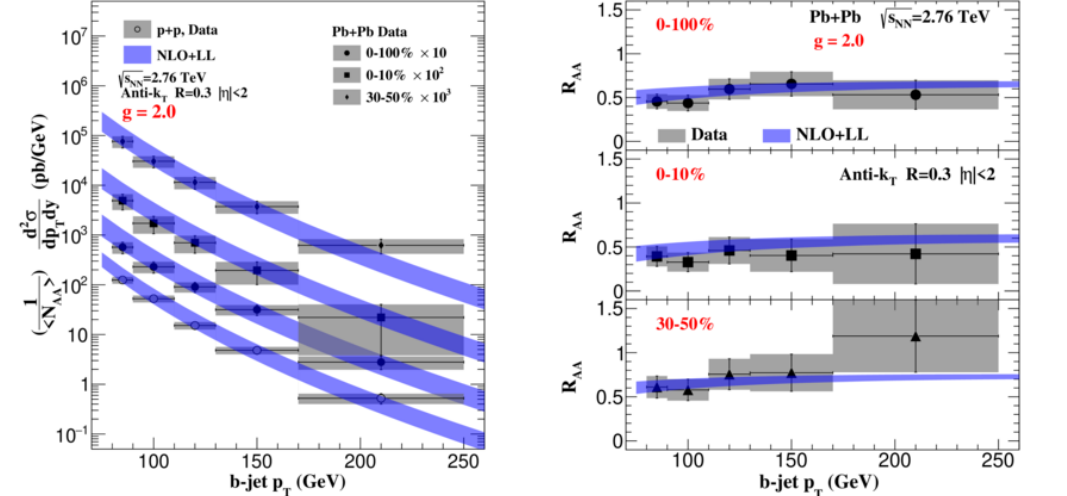
Figure 6 . The b-jet cross sections (left) in p+p and Pb+Pb collisions and the nuclear modification (right) for different centrality classes (0–100%, 0–10% and 30–50%), as indicated in the factor R AA legend. All theoretical predictions are present as the blue bands and are compared to the data from CMS measurements